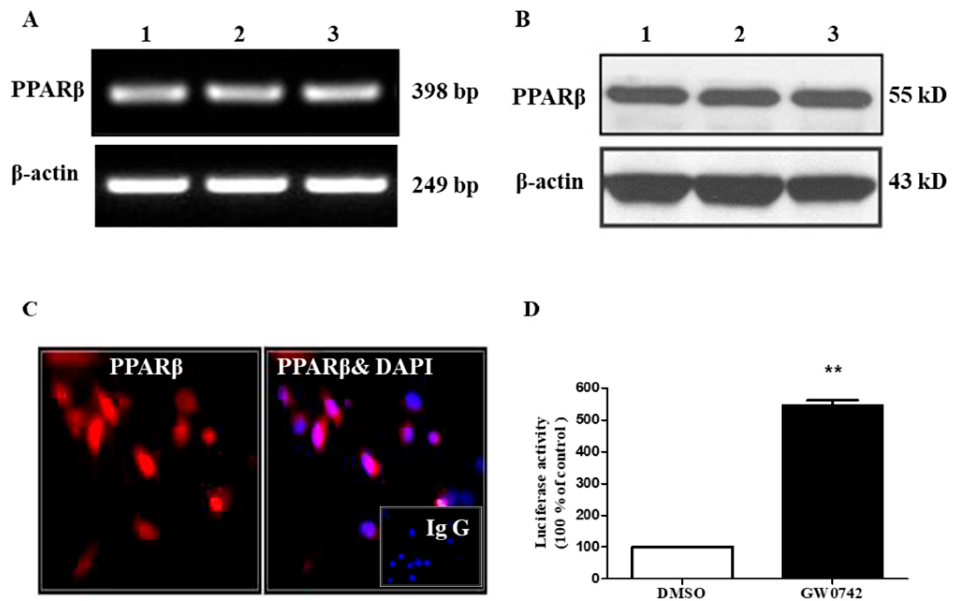
Figure 1. PPAR β / δ is functionally expressed in human mesangial cells. ( A , B ) Constitutive expression of PPAR β / δ in mesangial cells. Real-time PCR and Western blot assays were used to measure PPAR β / δ mRNA ( A ) and protein ( B ) expression in 3 preparations of mesangial cells. ( C ) The nuclear localization of PPAR β / δ in human mesangial cells as assessed by immunofluorescence. Red color represents PPAR β / δ immunoreactivity. The nuclei were stained with DAPI in blue. IgG was used as a negative control. ( D ) The effect of the PPAR β / δ agonist GW0742 on PPRE-luciferase activity. The cells were cotransfected with PPRE-luciferase plasmid and β -galactosidase vector for 24 h, followed by treatment with GW0742 (1 µ M) for 6 h. The luciferase activity was measured as described in the experimental procedure. ** p < 0.01 compared to DMSO; n = 3. PPAR β : PPAR β / δ